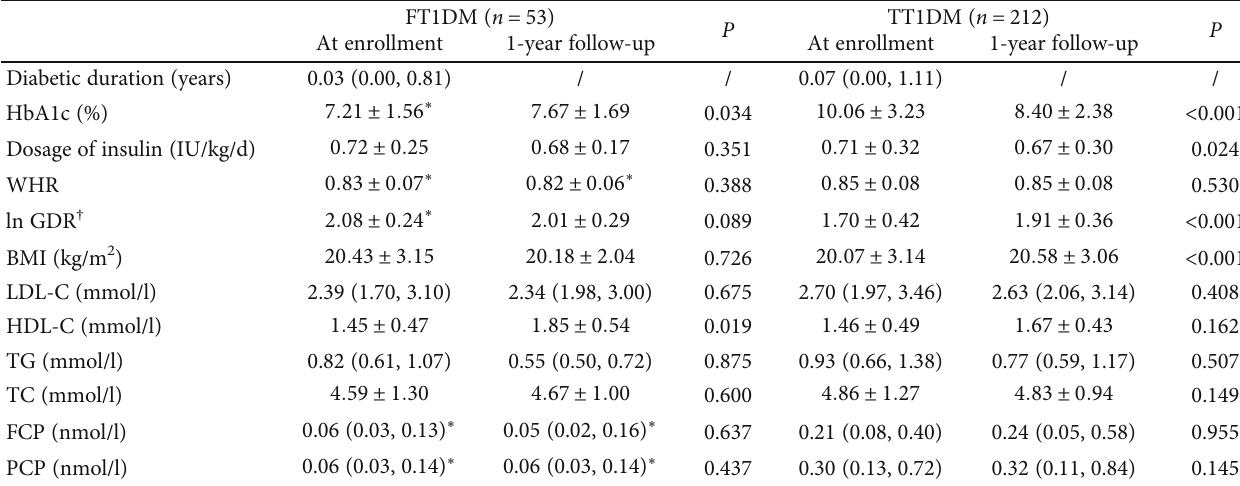
Table 2: Clinical characteristics during one-year follow-up between FT1DM and